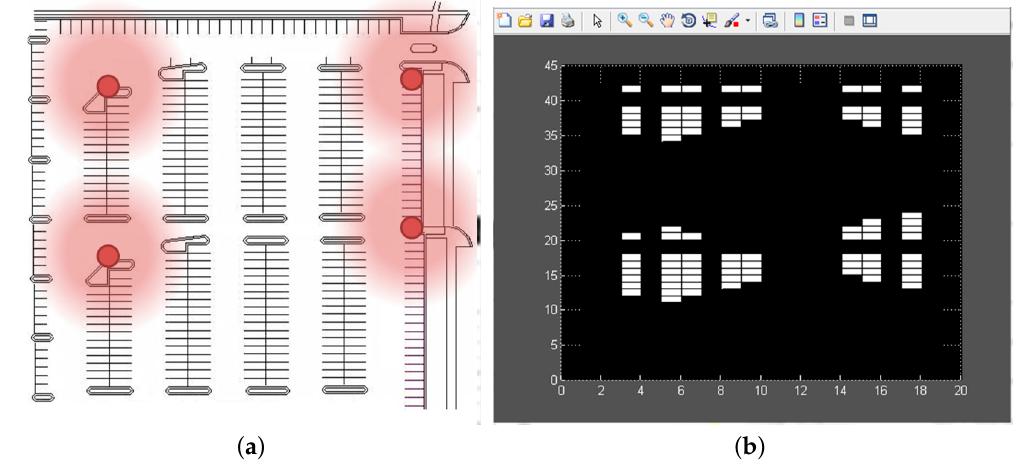
Figure 8. ( b ) Simulation of ( a ) parking facility with four Point Of Exit